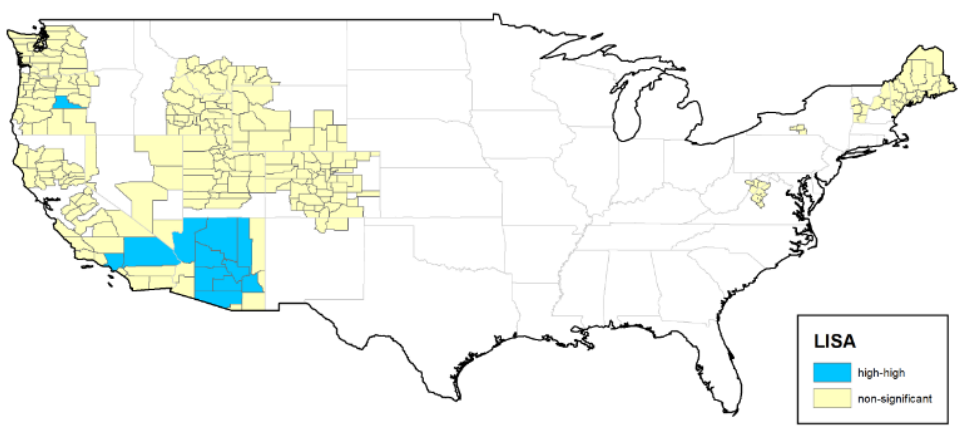
Figure 6. Spatial Autocorrelation of Fires by County. Spatial autocorrelation results show high fire frequency values surrounded by other high fire frequencies in the hotspots shown in teal (local indicator of spatial association (LISA)). The Local Moran’s I is 0.09, indicating that counties with high fire frequency are surrounded by other counties with high fire frequency ( p < 0.05). There were no